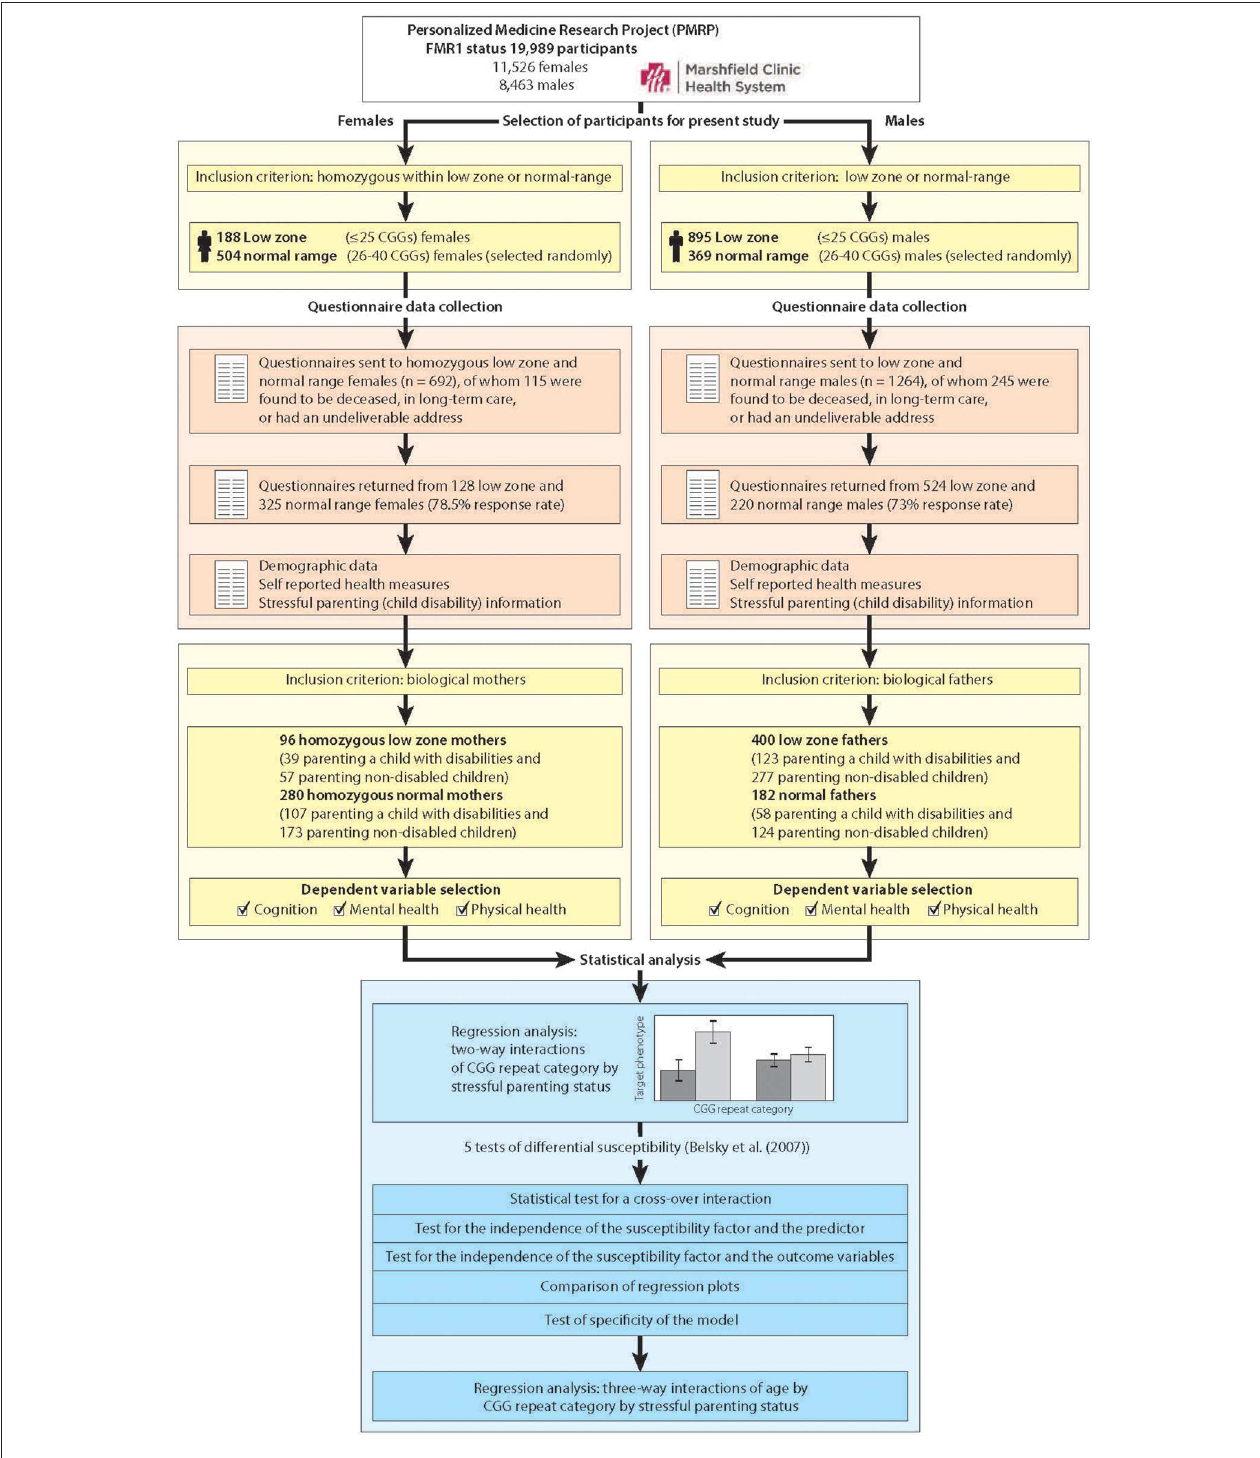
FIGURE 1 | Workflow overview of selection of participants, data collection, and statistical analysis.